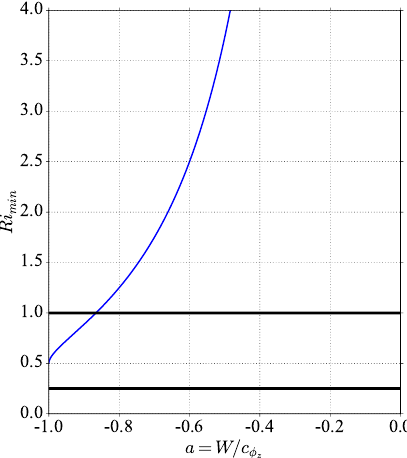
Figure A1. Minimum Richardson number over all wave phases, as a function of the amplitude parameter W